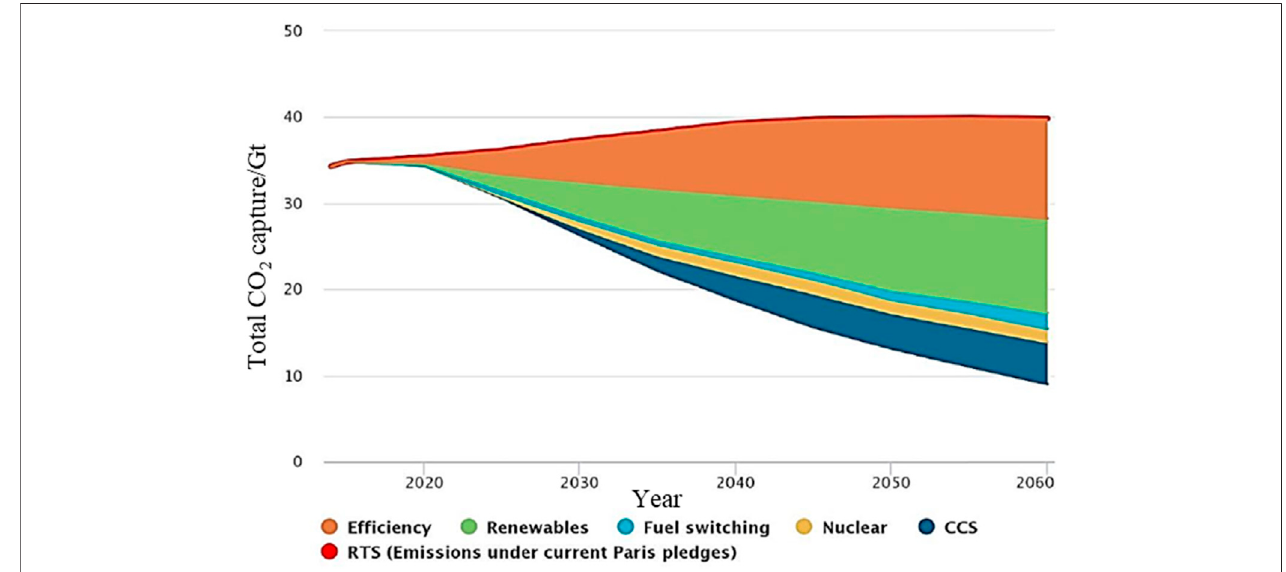
FIGURE 1 | The contribution rate of different technologies to carbon emission reduction in the 2DS scenario (IEA, 2017).